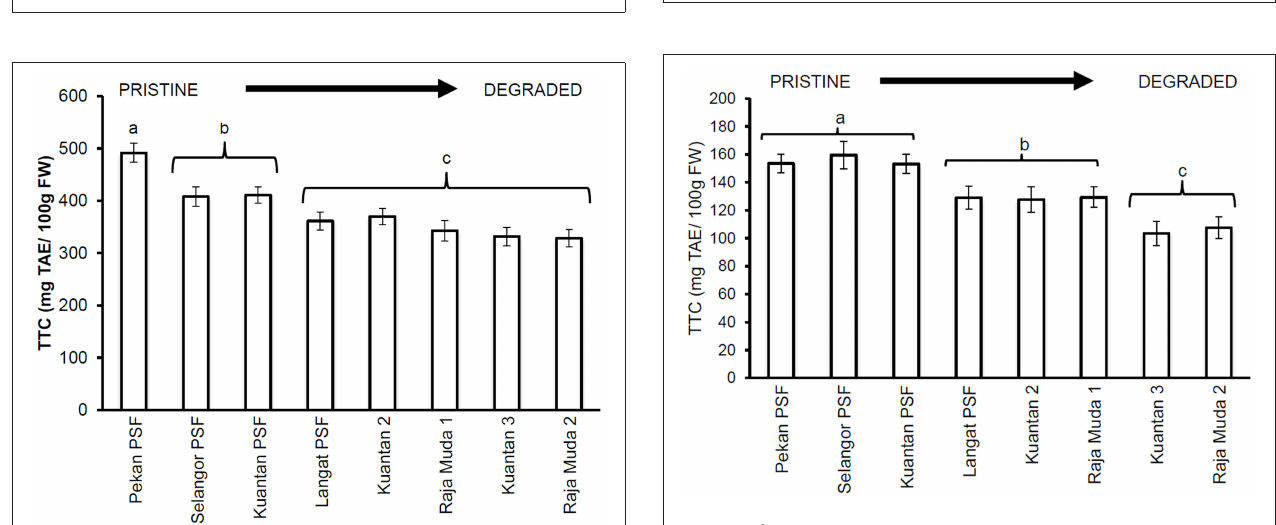
FIGURE 2 | Mean ( ± 1 SD ) total phenolic compounds in mature leaves of M. pruinosa at each peatland ( n = 45 except Pekan PSF, n = 15). Values followed by the same letter (a–e) are not significantly different at P < 0.05 as measured by the Tukey HSD test.